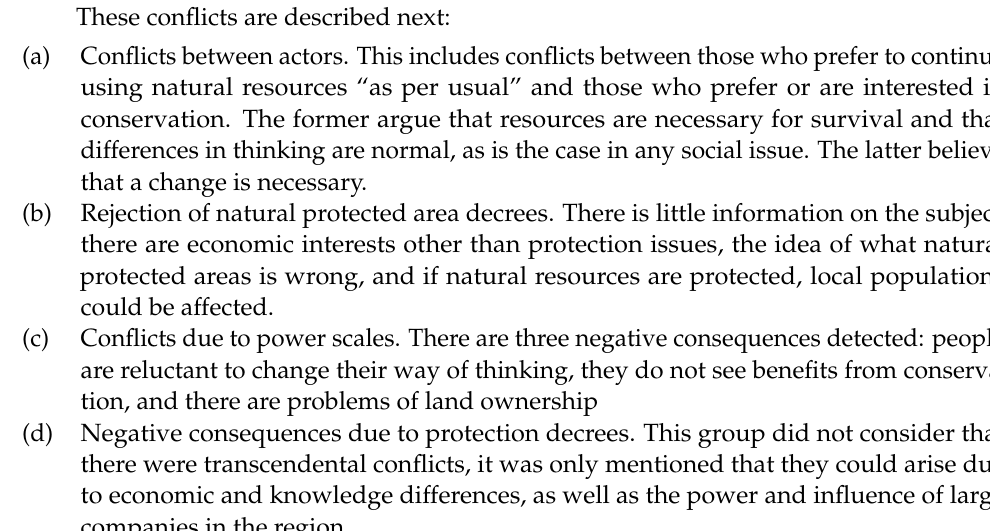
Figure 2. Frequency of responses by local conflict